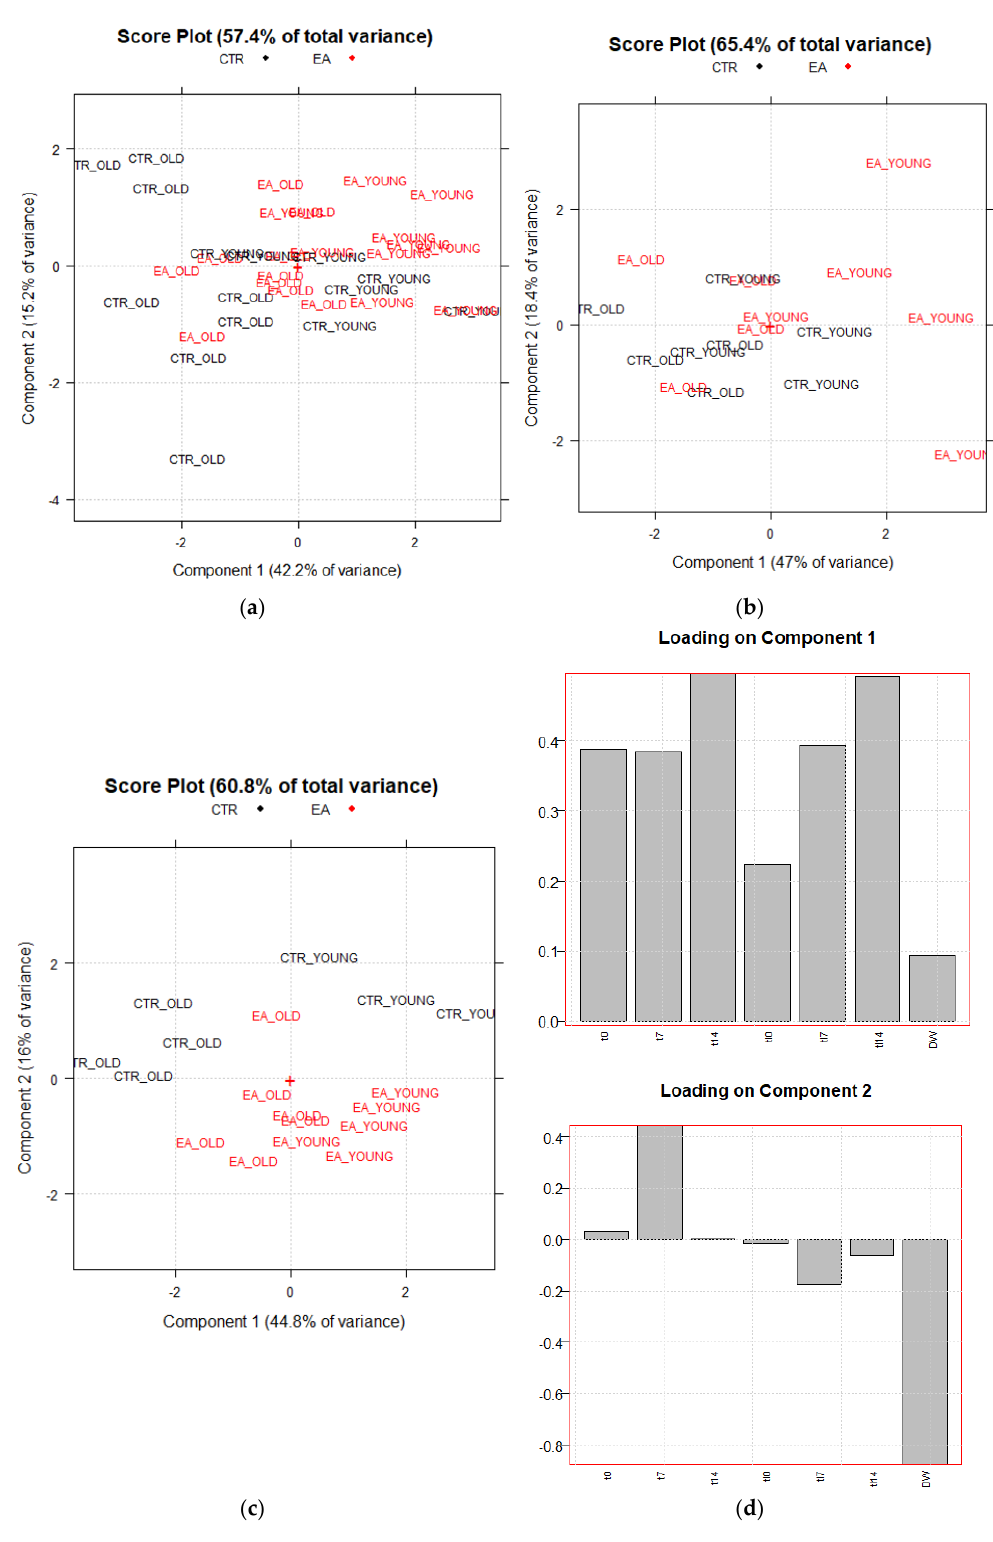
Figure 3. Principal Component Analysis results. PC1 vs. PC2 Score plots of PCA performed respectively on T 35,7 and F 17,7 data matrices ( a , b ). Score and Loading plots of PCA performed on S 18,7 data matrix ( c , d ). CTR_YOUNG: untreated young mice; CTR_OLD: untreated old mice; EA_YOUNG: EAm-treated young mice; EA_OLD: EAm-treated old